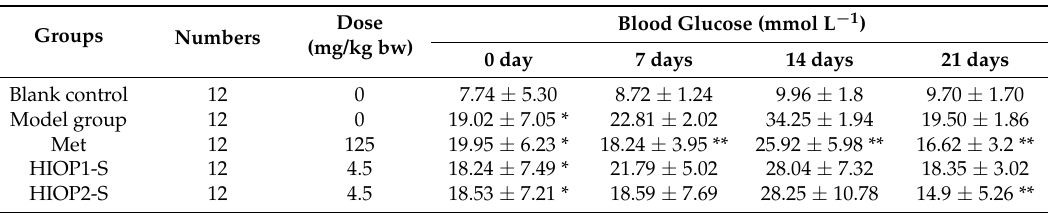
Table 3. Effect of HIOP1-S and HIOP2-S on the fasting blood glucose levels of Streptozotocin-induced diabetic mice.